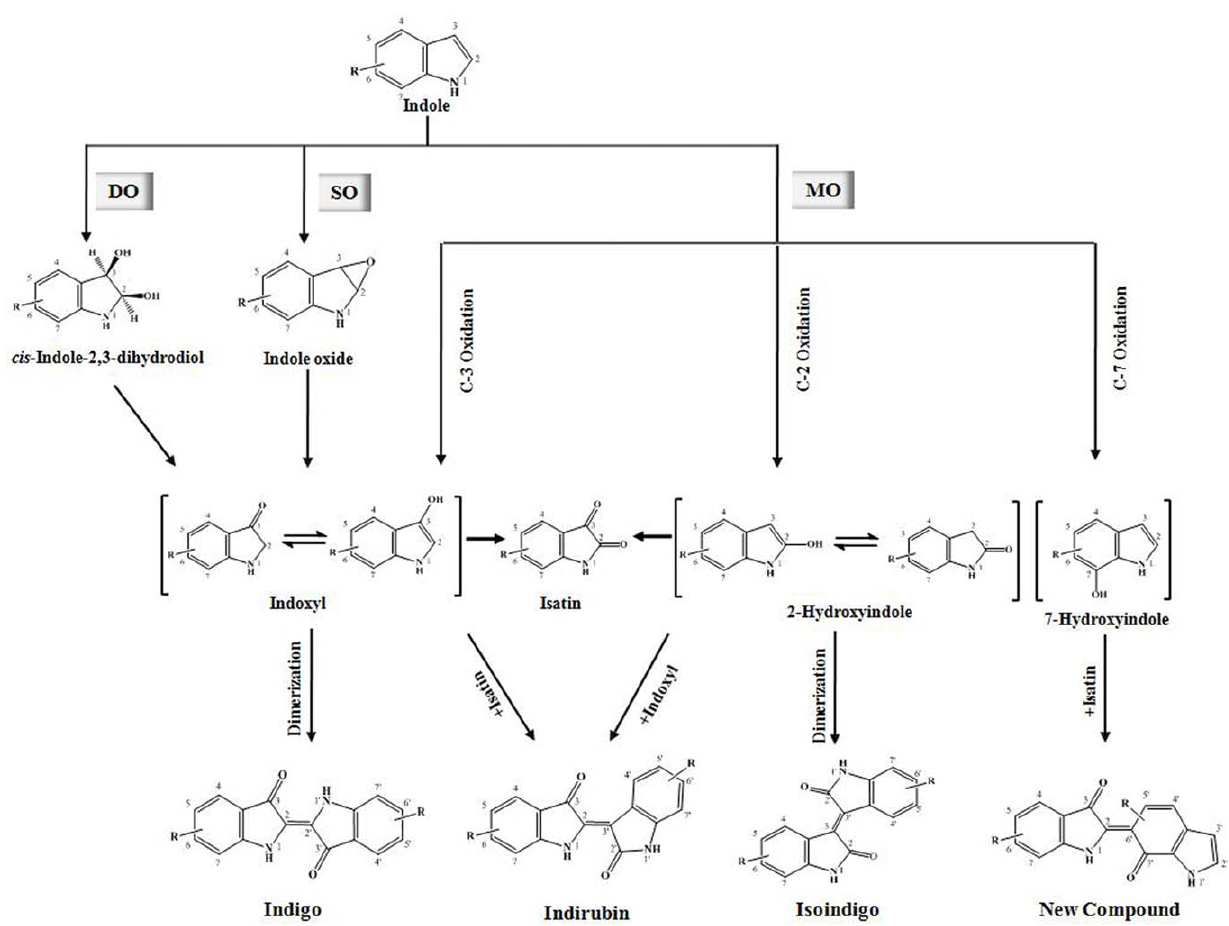
Figure 5. Summary of transformation pathways of indole by various oxygenases. DO. dioxygenase; SO. styrene oxygenase; MO. monooxygenase. R represents for substitute group i.e. methyl-, chloro-, methyoxy-, etc. The pathways catalyzed by strain PH_ IND could be proposed by C-3 oxidation and C-7 oxidation pathways. The indole is firstly hydroxylated at the C-3 positions to form indoxyl (3-hydroxyindole) by strain PH_ IND , which undergoes further oxidation to form isatin as well as the indigoids precursors. Finally, two molecules of indoxyl polymerize to form indigo, and indoxyl can form indirubin with isatin. And the new compound is formed by 7-hydroxyindole and isatin. doi:10.1371/journal.pone.0044313.g005 and cloned into the plasmid pET-28a( + )/PH digested with the expression, the recombinant plasmids were introduced into E. coli same enzymes. The resulting plasmid were designated as pET- BL21 (DE3), and the recombinant strains were designated as 28a( + )/PH -Asn-202 and pET-28a( + )/PH -His-139. For protein PH_ IND -Asn-202 and PH_ IND -His-139, respectively.